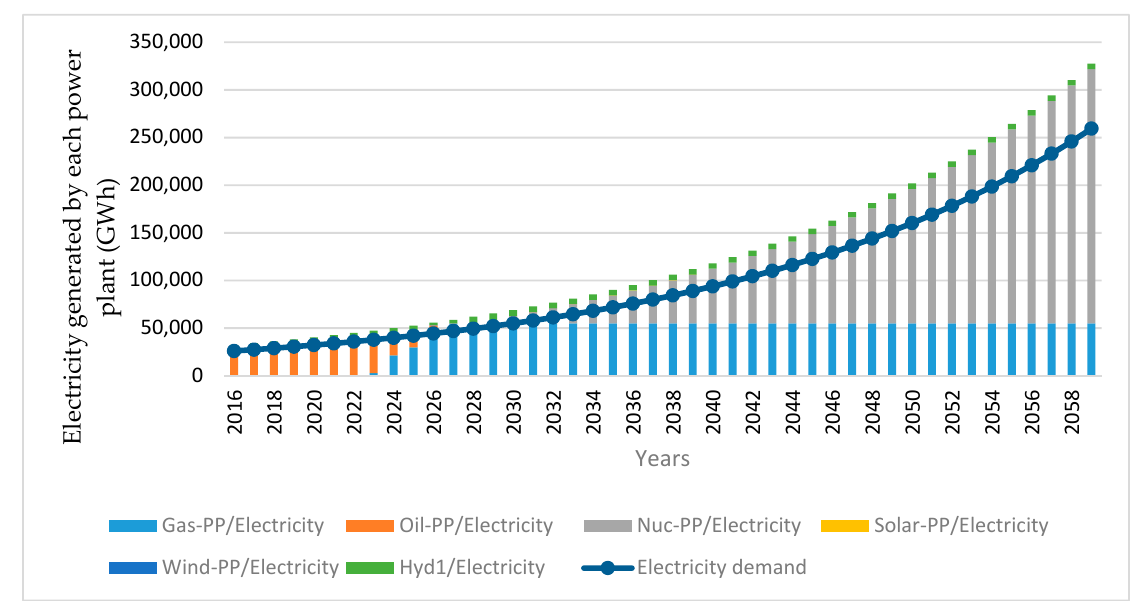
Figure 6. Increase in electricity production and demand from all power plants with limit on CO 2 emission using MESSAGE code for the modeling period under study. Table 7 comparison between the contributions of each power plant in both scenarios.